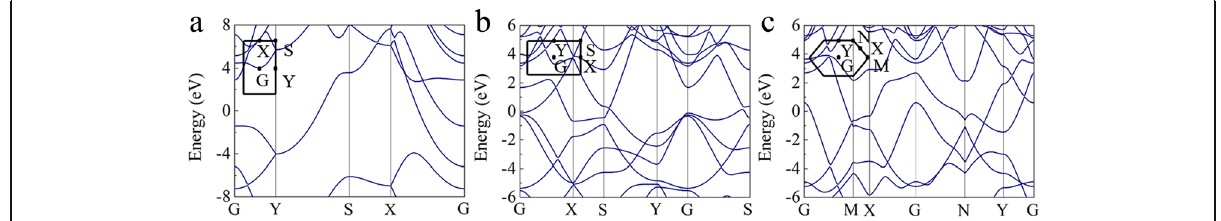
Fig. 3 Calculated band structures for a buckled triangular, b β 12 , and c χ 3 boron sheets. The Fermi energy was set to zero. The high-symmetry points are shown on the left